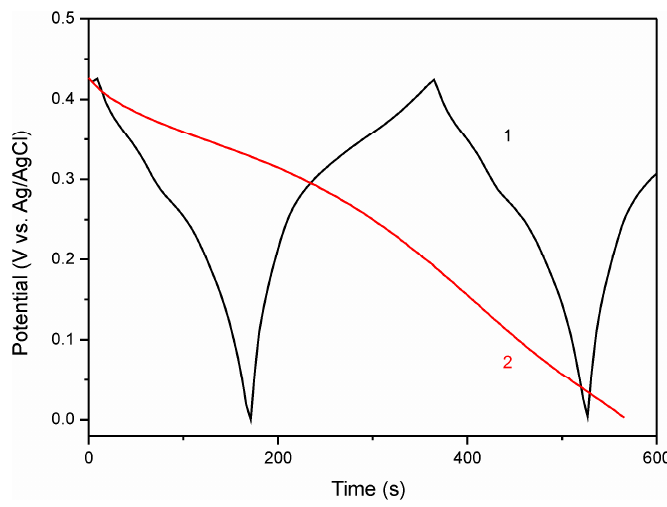
Figure 6. The galvanostatic charge/discharge (GCD) curves of Co 3 O 4 ( 1 ) and Re-Co 3 O 4 ( 2 ) electrodes at current density of 0.24 A g −1 and 0.38 A g −1 , respectively.